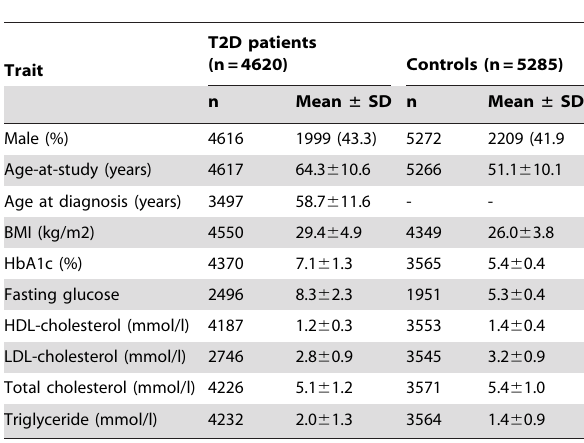
Table 1. Clinical characteristics of the study participants.